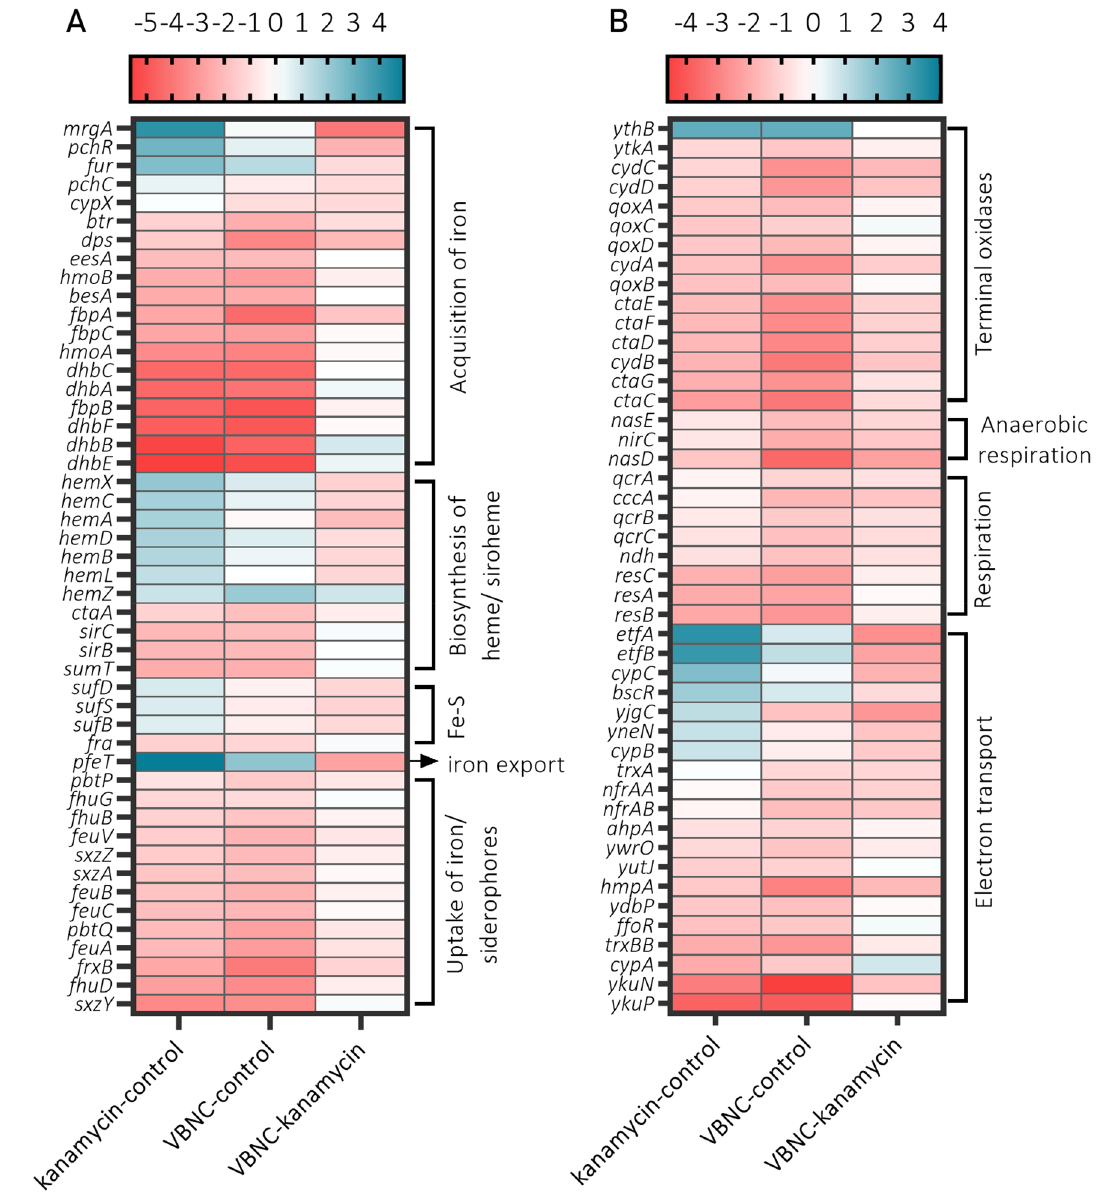
Figure 5. TopHit DEGs involved in iron homeostasis and respiration in B. subtilis VBNC and kanamycin- sensitive cells. Heatmaps of DGEs ratio values ( p value ≤ 0.05 and a log 2 FC ≥ 2) involved in ( A ) iron homeostasis and ( B ) respiration in B. subtilis 168. The analysis shows significantly different expressed genes in at least one of the experimental contrasts. The fold differences are represented with the color bar above each heatmap. Heatmaps were generated in GraphPad Prism 8 Software (GraphPad Software, San Diego, California USA, www. graph pad. cell wall turnover and cell separation 63 , and downregulation of the members of mblK operon associated with the control of cell shape and division ( yisK ) 64 , strongly point to reduced synthesis and disassembly of peptidoglycan and inhibited cell proliferation. Finally, the analysis of transcription profiles of VBNC and culturable cells showed changes for genes involved in response to iron limitation. The downregulation of several members of Fur-regulated operons fbpB dhbB , ykuJ and nasF indicates strong inhibition of iron-scavenging components and reduced nitrate assimilation, most likely due to the increased pools of free iron and oxidative stress in VBNC cells 65–67 . The analysis of TopHits data ( p value ≤ 0.05 and a log 2 FC ≥ 2) additionally confirmed that VBNC cells activate the iron export ( pfeT ) and downregulate the genes involved in iron acquisition (Fig. 5A). Changes in the expression of genes involved in the respiration show that VBNC cells shut down most of the respiration systems with an exception of ythB an alternative terminal quinol oxidase 68,69 and etfAB encoding electron transfer flavoprotein involved in fatty acid β-oxidation 70 (Fig. 5B).